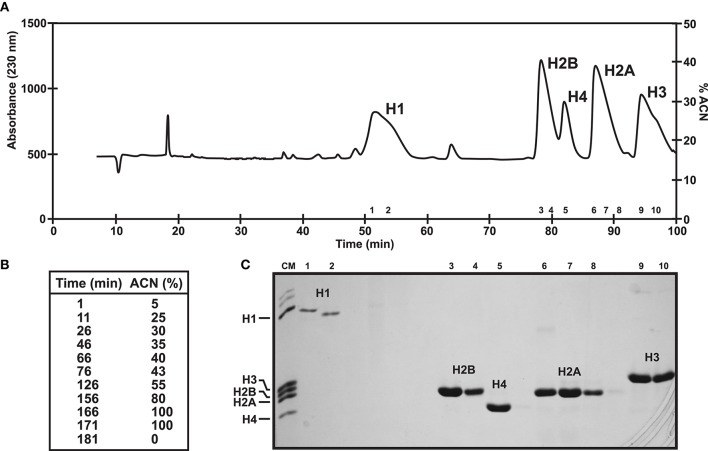
Histone fractionation in bivalves. (A) RP-HPLC chromatogram of 1 mg of histones from male gonad of the variegated scallop Chlamys varia using a Vydac C18 column (300 Å pore diameter). Peaks indicate the elution of the five histone families. (B) Acetonitrile gradient employed in this experiment. (C) SDS-PAGE separation of selected fractions corresponding to each peak. CM, chicken erythrocyte histones used as molecular marker.